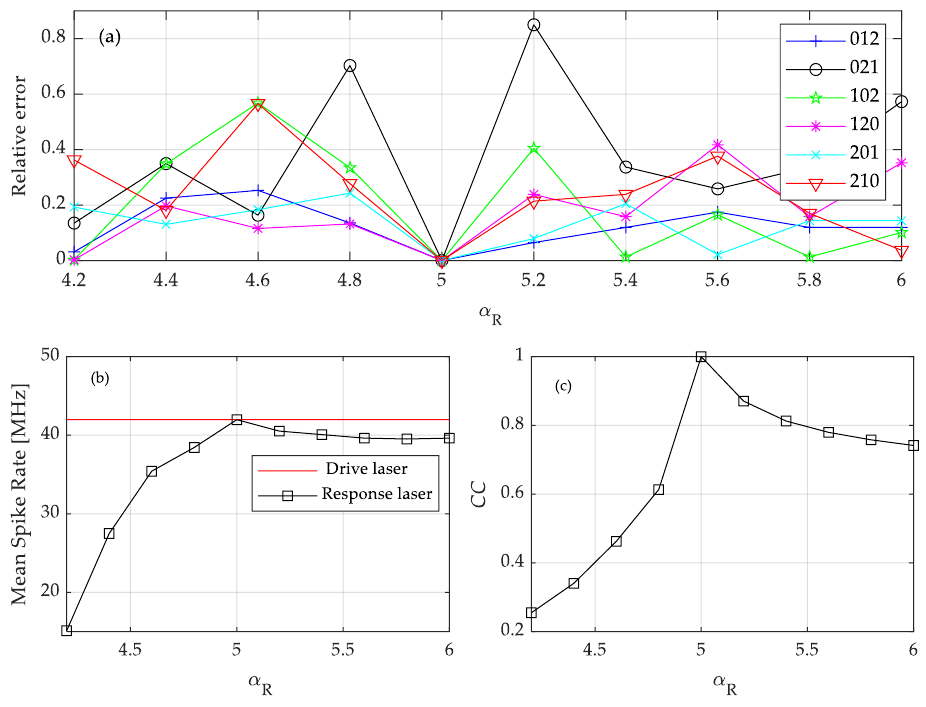
Figure 8. Effect of linewidth enhancement factor mismatch on system transmission. ( a ) Event probability error, ( b ) pulse rate, and ( c ) correlation coefficient .